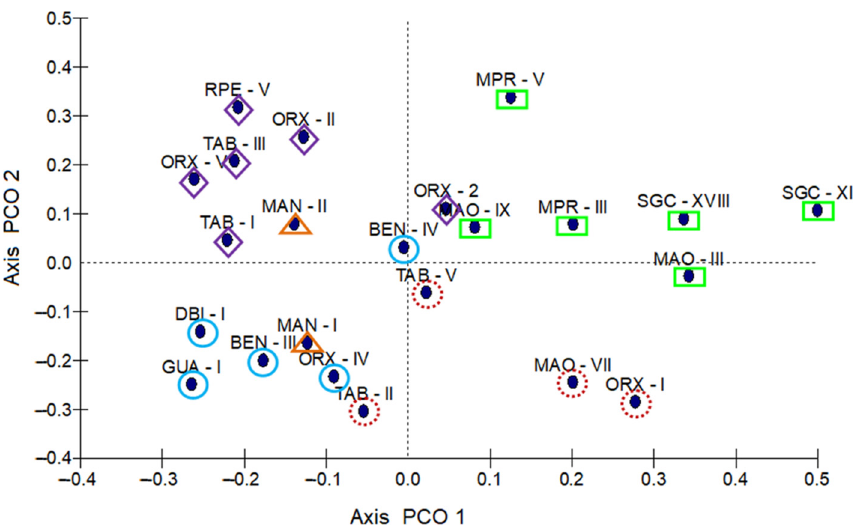
Figure 3. Graphical dispersion obtained by principal coordinate analysis (PCA) on the first two axes of 23 genotypes of Capsicum chinense , characterized by 21 morphological descriptors. The colors that delimit the genotypes correspond to groups identified in Figure 2: orange, group 1; green, group 2; purple, group 3A; blue, group 3B; and red, group 3C. Table 2. Means of the traits total fruit weight per plant (TFW), number of fruits per plant (NF) and mean fruit weight (FW), evaluated in 25 weekly harvests, fruit length (FL), fruit diameter (FD), fruit length to diameter ratio (DLR), fruit wall thickness (FWTh) and seed size (SS) were evaluated in a sample of 15 fruits per plot of 23 “pimenta-de-cheiro” C. chinense